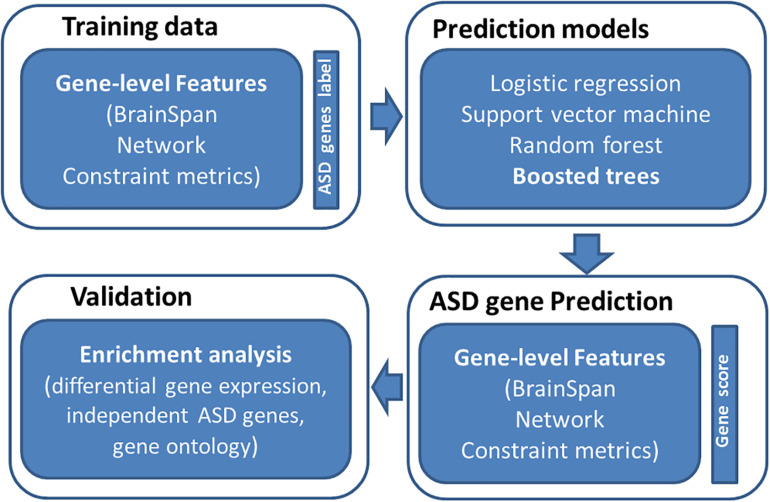
Overview of study design. We first collected training data of labeled genes (121 true positive genes and 963 true negatives) and their associated features (spatiotemporal gene expression values from BrainSpan, network features, and gene-level constraint metrics). We then applied four machine learning algorithms to predict ASD genes, including logistic regression, support vector machine, random forest, and boosted trees. The boosted trees achieved the best prediction performance and was employed to predict ASD risk genes across the genome. We further evaluated predicted risk genes through enrichment analyses.